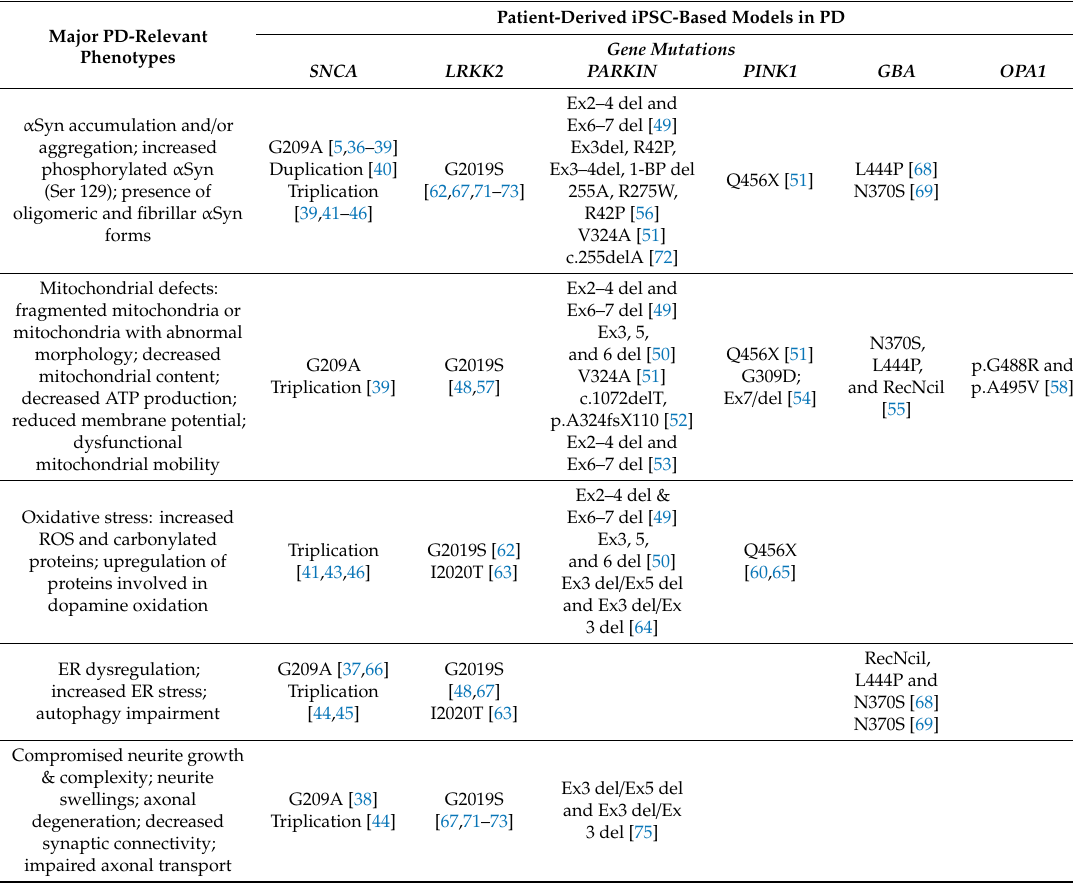
Table 1. Major phenotypes observed in PD hiPSC-derived neurons. This table summarizes key pathogenic phenotypes associated with PD mutant neurons as described in the cited